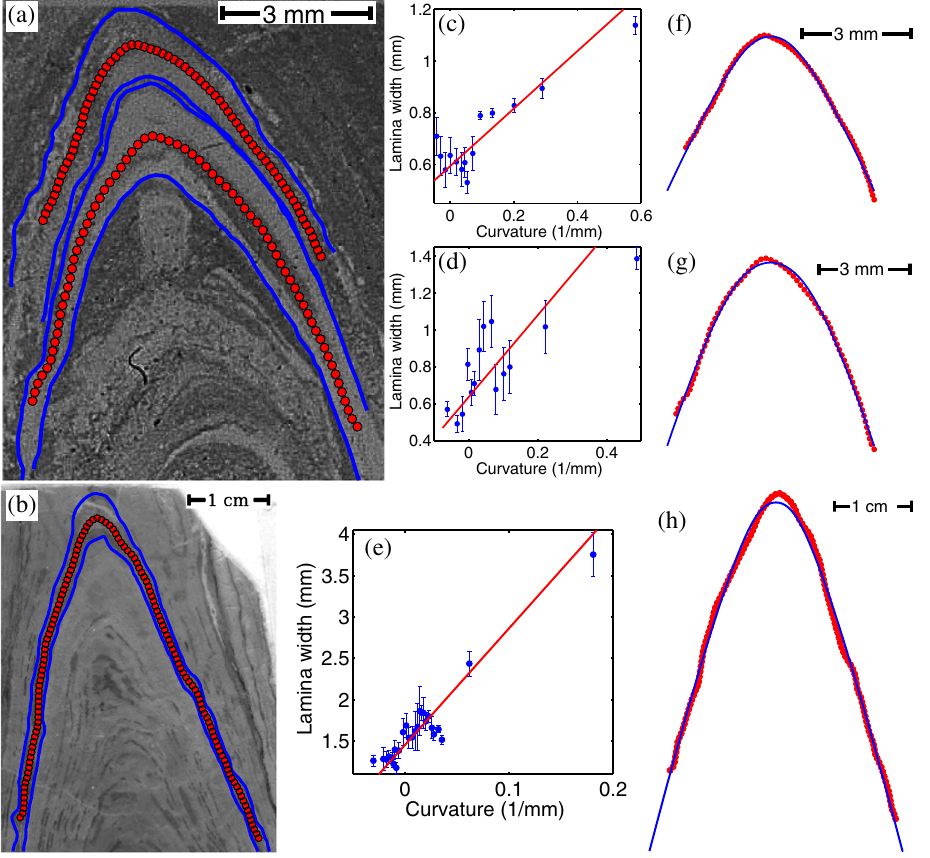
FIG. 5. Comparison of curvature-driven growth to the shapes of large and small conical stromatolites sectioned vertically through the center. (a) Thin section through a 2 : 9 (cid:1) 10 9 -yr-old conical stromatolite (photograph) [38]. Solid blue lines represent the upper and lower boundaries of two laminas. The red points lay along a curve equidistant from the traced laminas. (b) Thin section of a 1 : 6 (cid:1) 10 9 - yr-old stromatolite from the Bakal Formation [39,40] with traced laminas. (c) The thickness of the upper laminas from (a) increases with lamina curvature ( R 2 ¼ 0 : 81 , p < 10 (cid:2) 17 , (cid:1) ¼ 1 : 9 (cid:8) 0 : 7 mm ), consistent with Eq. (15). (d) Similar agreement is found for the lower lamina ( R 2 ¼ 0 : 64 , p < 10 (cid:2) 8 , (cid:1) ¼ 3 : 5 (cid:8) 1 : 7 mm ) and in the (e) Proterozoic sample shown in (b) ( R 2 ¼ 0 : 88 , p < 10 (cid:2) 44 , (cid:1) ¼ 9 : 7 (cid:8) 1 : 6 mm ). (f),(g) Fitting two parameters, the measured shapes of the (f) upper and (g) lower laminas (points) are consistent with the shape (solid curve) of a lamina growing by the curvature-driven growth equation (19). (f) Fit of the sample from (b) to Eq. (19). All samples are cut through the central axis of the